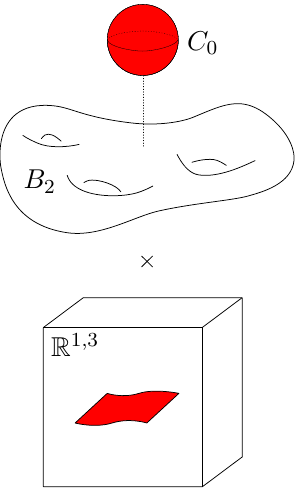
Figure 3 . We consider F-theory compacti(cid:12)cations on limits with emergent strings feature a (cid:12)bration structure C 0 shrinks relative to B 2 . The role of the emergent string is played by a D3 brane wrapped on C 0 . The curve C 0 can either be a torus leading to a Type II string, or a rational curve leading to a heterotic